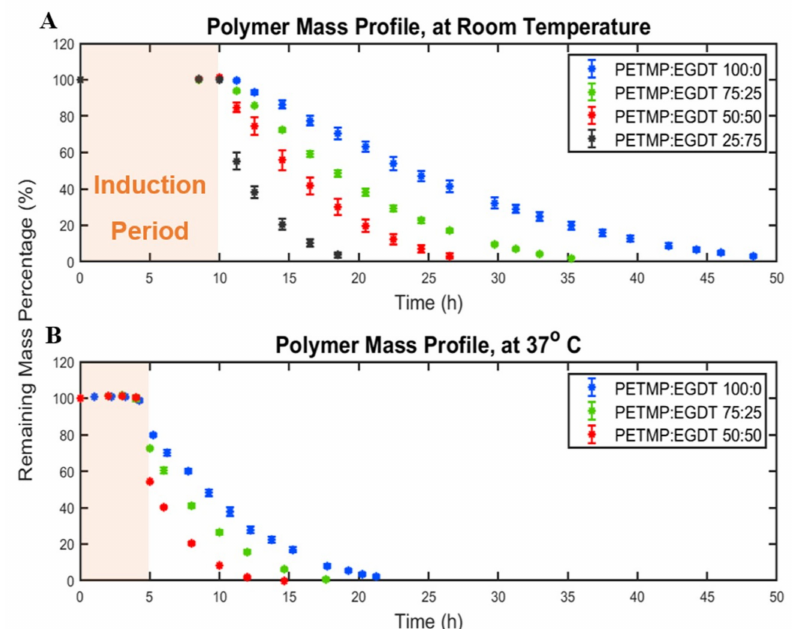
Figure 2. The impact of temperature on polymer mass loss profile. The remaining mass percentage of ( A ) four polymer compositions at room temperature and ( B ) three polymer compositions at 37 ◦ C. Higher temperature leads to shorter induction periods and shorter erosion